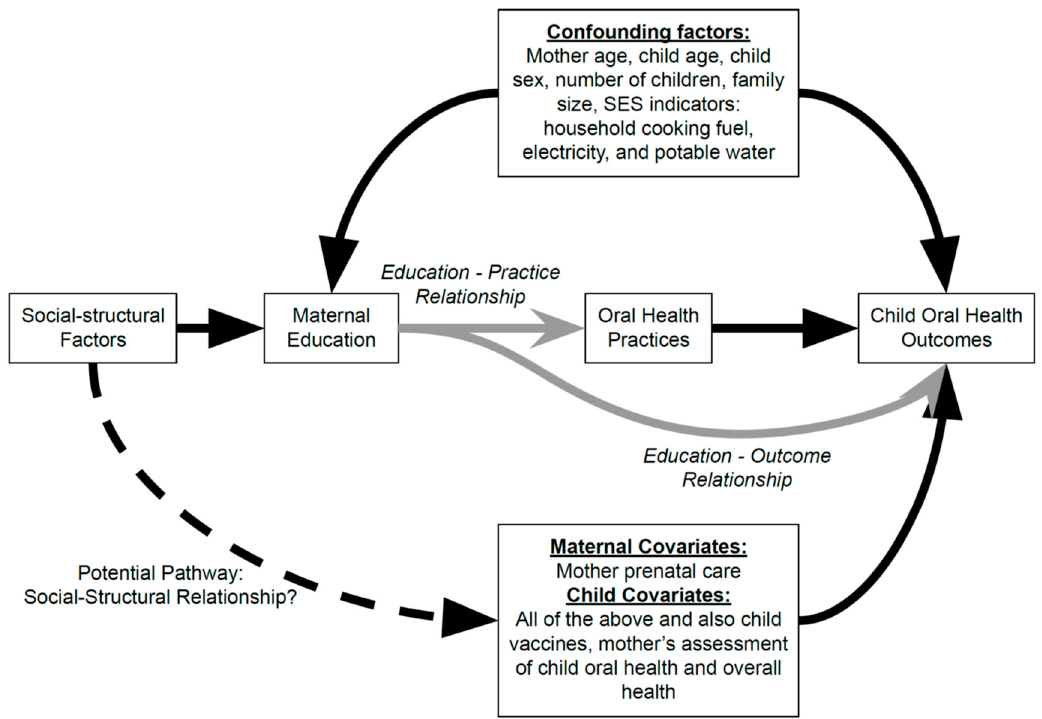
Figure 2. Hypothesized Relationship between Maternal Education, Maternal-Child Oral Health and Nutrition Practices, and Child Oral Health Outcomes. Gray: Our pathways of interest; Dotted : A potential, unexplored pathway.